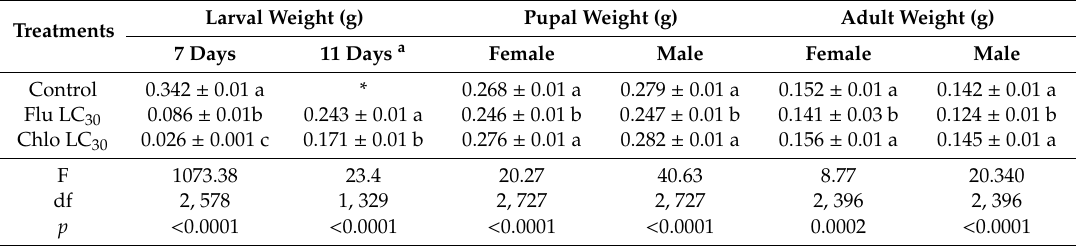
Table 4. Sublethal e ff ects of flubendiamide (Flu) and chlorantraniliprole (Chlo) on larval weight after 7 days of exposure to treated diets, after 4 additional days on untreated diet (11 days total), and on pupal and adult weight of Chloridea virescens under controlled laboratory environmental conditions (25 ± 2 ◦ C, 60 ± 10% RH, and 14L: 10D).